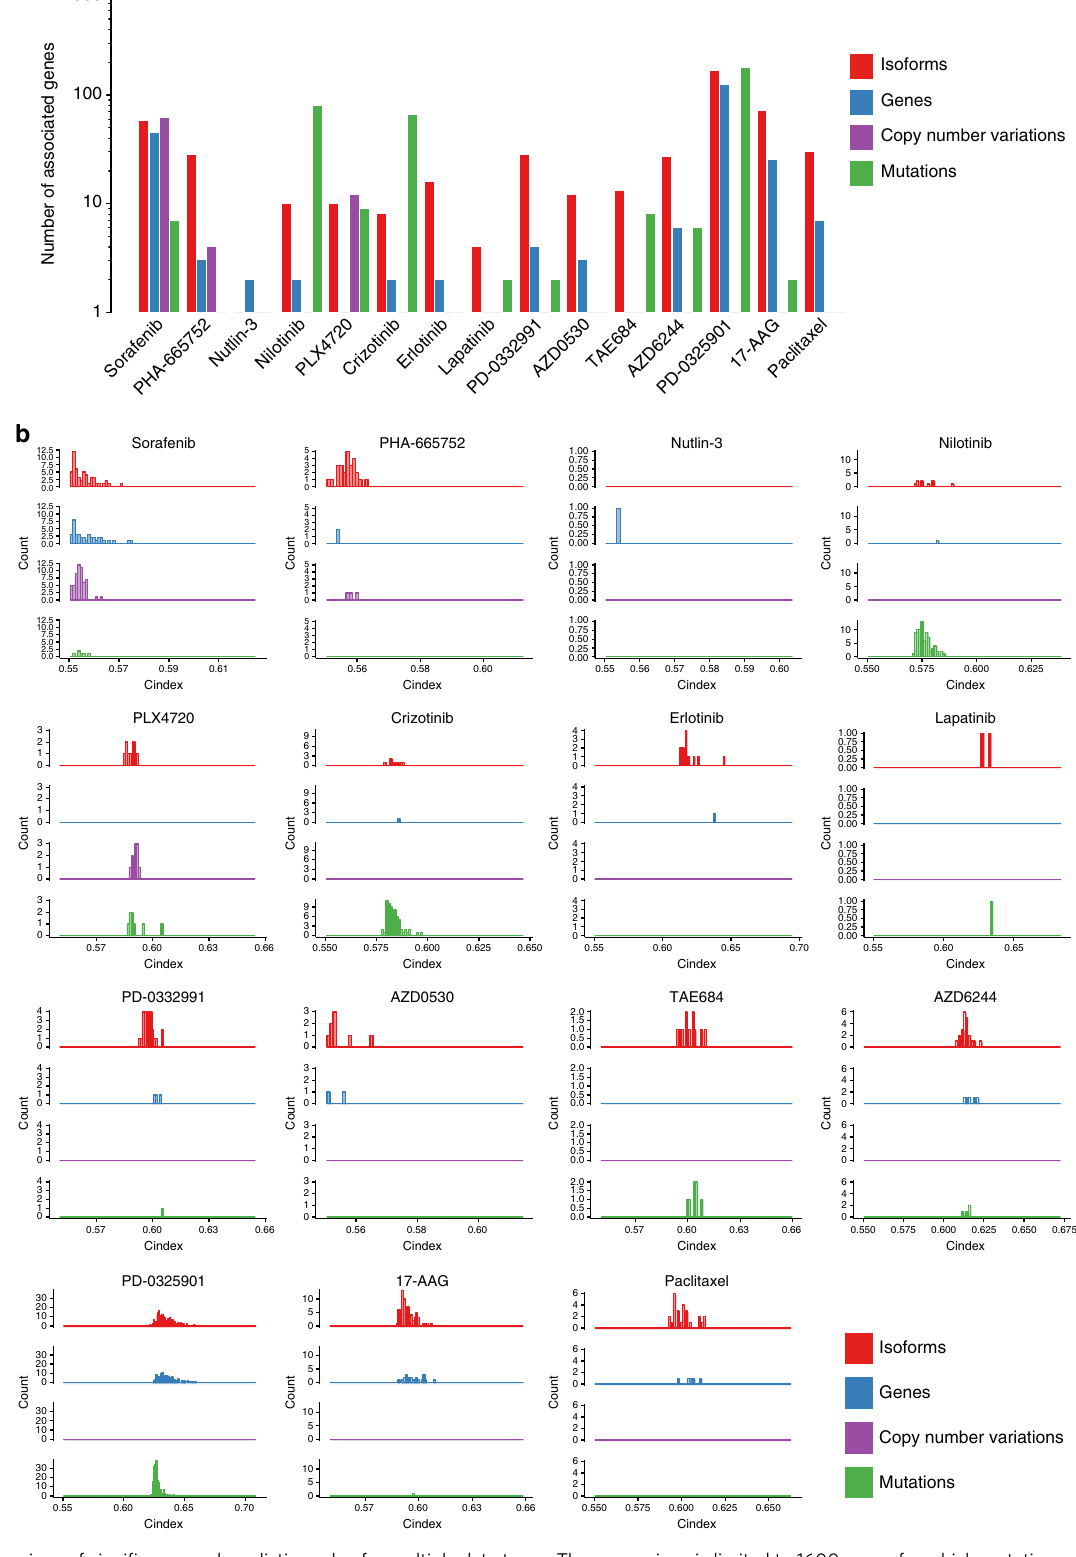
Fig. 3 Comparison of signi fi cance and predictive value for multiple data types. The comparison is limited to 1600 genes for which mutations, copy number variation, and expression data were available. a Number of signi fi cant (FDR < 5%) biomarkers at the level of gene expression, isoform expression, mutation, and ampli fi cation. b Distribution of concordance indices (predictive value) of the signi fi cant biomarkers with respect to data type